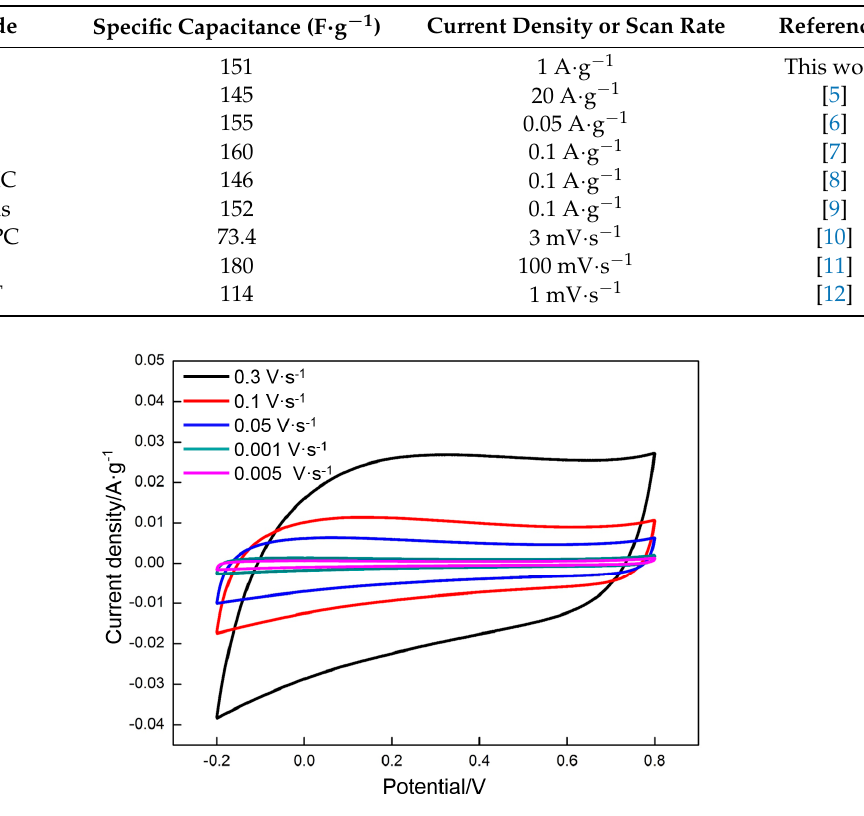
Figure 13. CV curves of RGO at different scan rates.